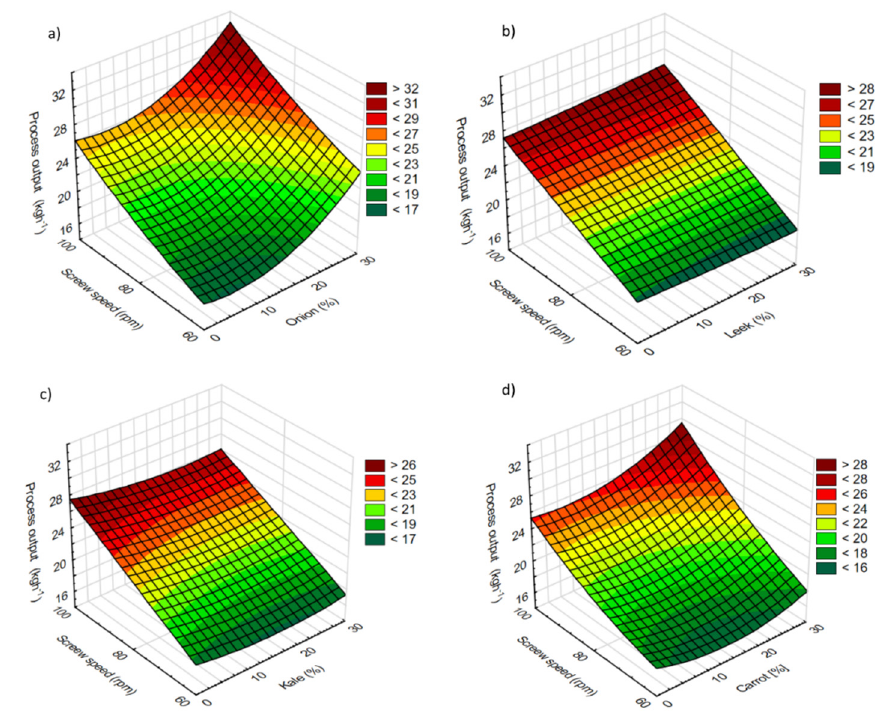
Figure 2. Response plots of processing efficiency results during the extrusion-cooking of potato-based snack pellets supplemented with addition of various vegetables: ( a ) onion, ( b ) leek, ( c ) kale and ( d ) carrot.